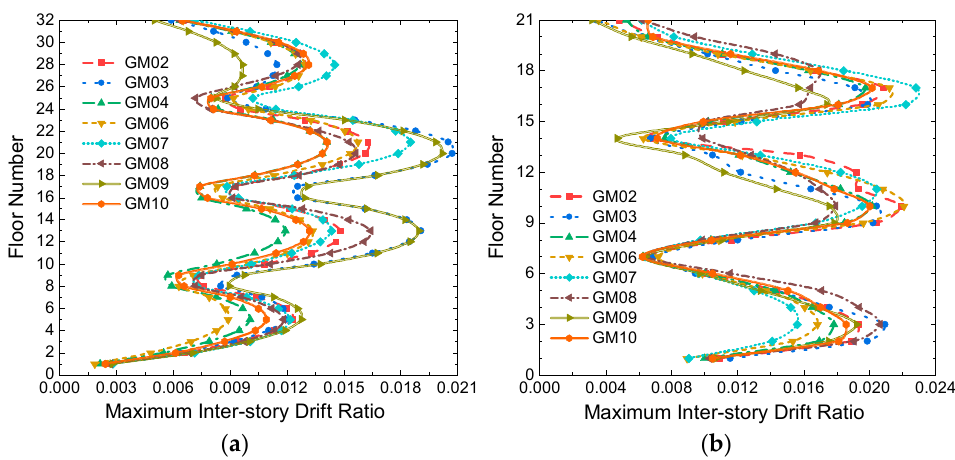
Figure 8. Maximum inter-story drift ratios when the 1/50 criterion is reached. ( a ) The ratio on each floor in the mega-structure; ( b ) the ratio on each floor in sub-structures. Vertical axes are sub-floors numbered from the bottom up. Each of the 4 mega-floors includes 8 sub-floors, and each of the 3 released sub-structures includes 7 sub-floors.